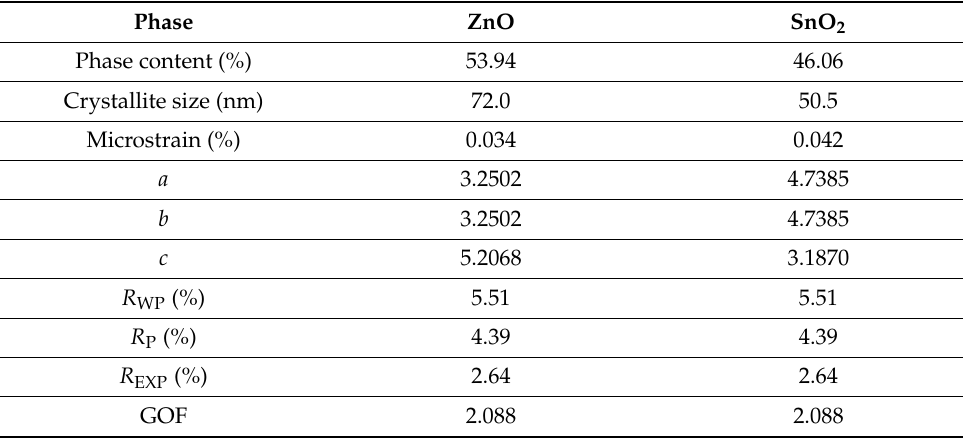
Table 2. The phase composition, crystallite size, and microstrain of ZT–1 by Rietveld refinement.